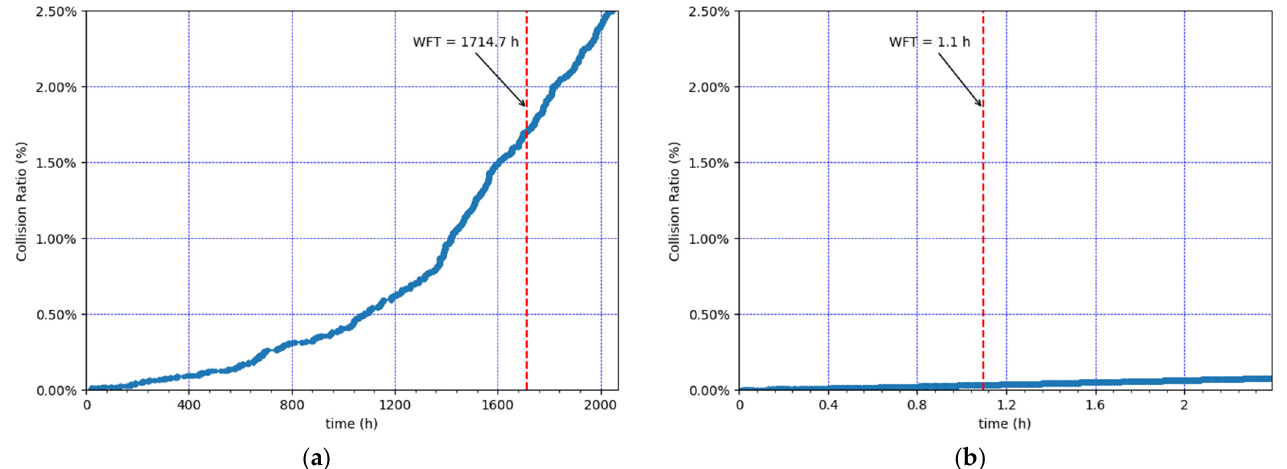
Figure 6. Evolution of cumulative collisions at the gateway over time. ( a ) Lowest load: 30 CEDs, using an EDL of 0.9 packets/h. ( b ) Highest load: 100 CEDs, using an EDL of 18 packets/h.